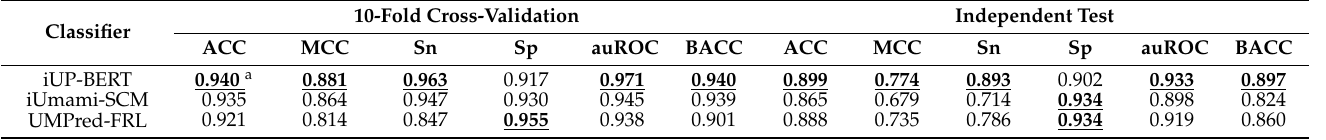
Table 4. Cross-validation and independent test results of iUP-BERT and the existing